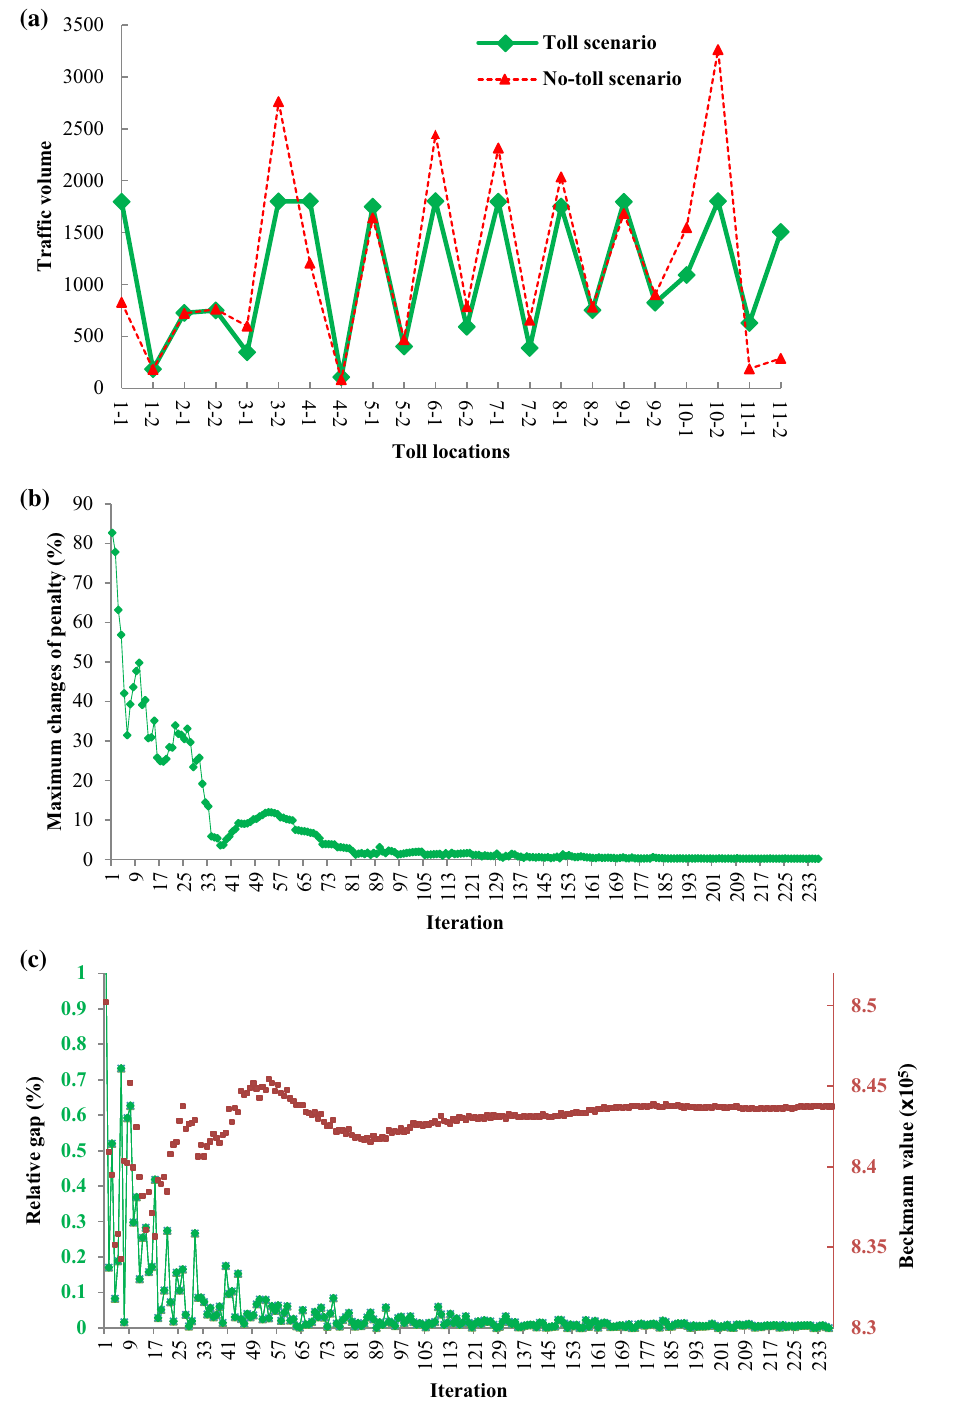
Fig. 6 Winnipeg case study: a traffic volume on the screen line before and after TSS; b maximum of changes in penalty; c convergence